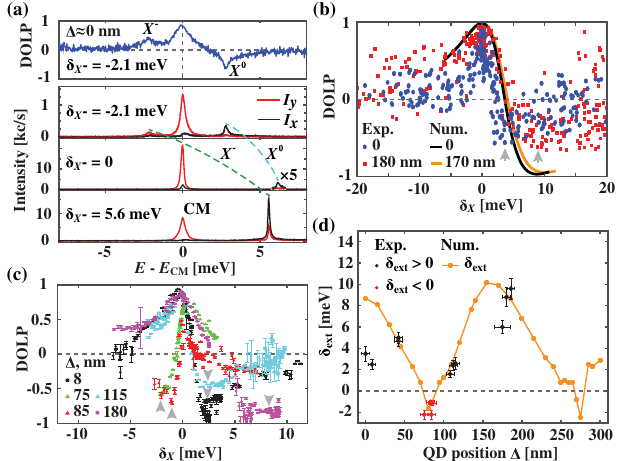
FIG. 3. (a)QDpolarization-resolvedemissionspectraatdifferent X − -CM detunings δ versus the photon energy relative to the CM X − energy. The bottom and top panels in (a) show the polarized-PL spectra for a structure with Δ ≈ 0 and various values of δ and X − − 2 . 1 meV. The exciton-CM corresponding DOLP for δ X − ¼ detuning was varied using water vapor deposition and temperature tuning. (b) Numerically simulated DOLP spectra for Δ ¼ 0 and 170 nm and experimental DOLP value statistics versus the exciton- CM detuning. The experimental points were extracted from polarization-resolved PL spectra measured at P ¼ 170 W = cm 2 and T ¼ 10 K for 61 and 96 different cavities with Δ ¼ 0 and 180 nm, correspondingly. (c) Exciton DOLP values versus the exciton-CM detuning for the QD positions Δ varying from 8 to 180 nm. DOLP traces were obtained by tuning the excitonic transitions across the CM energy as in (a) (see also Appendix A, Fig. 12). (d) Numerically simulated and experimental extremal exciton-CM detuning δ extracted from numerical and exper- ext imental DOLP traces for different values of Δ . In (b) and (c), δ X corresponds to the detuning of observed negatively, neutrally, and positively charged excitons and biexcitons relative to the CM energy. Gray arrows mark experimental δ ext